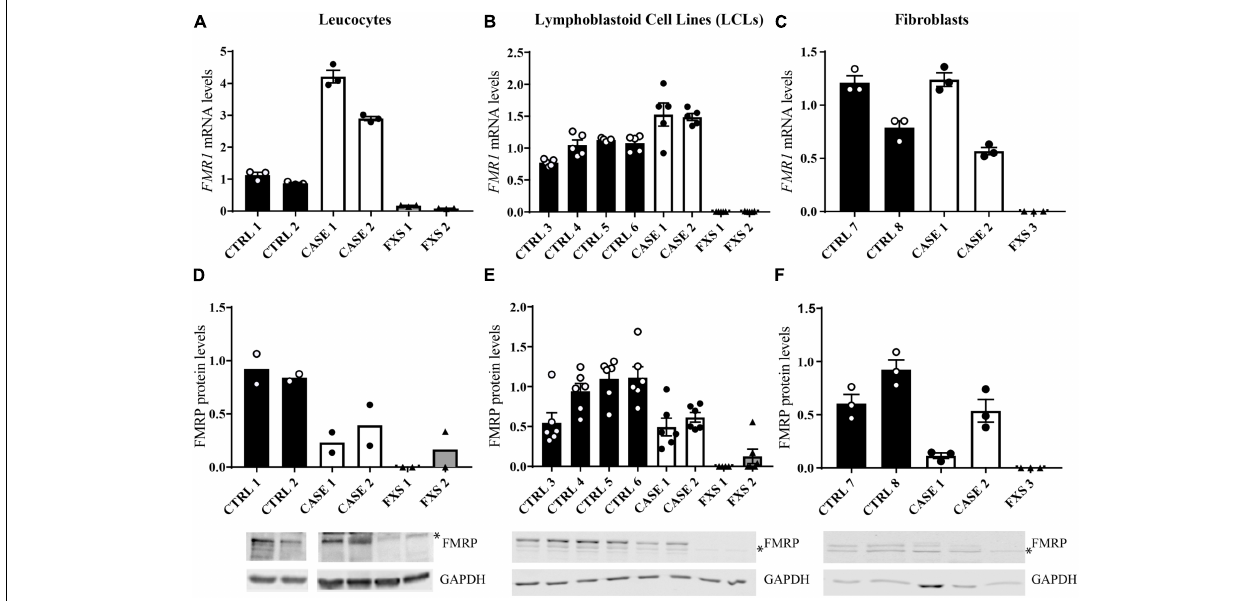
FIGURE 2 | Analysis of FMR1 mRNA and FMRP expression in different tissues. (A–C) Quantitative RT-qPCR detecting FMR1 mRNA relative expression in the tissues tested, normalized with the housekeeping HPRT1 mRNA [ n = 3–5, technical replicates, independent experiments for (B,C) ]. (D–F) Quantification of FMRP levels compared to GAPDH levels [ n = 2–6 technical replicates, independent experiments for (E,F) ]. The error bars indicate the standard error. Lower panels, representative Western blots from the different cell types analyzed. ∗ indicates a non-specific signal which has been subtracted in the